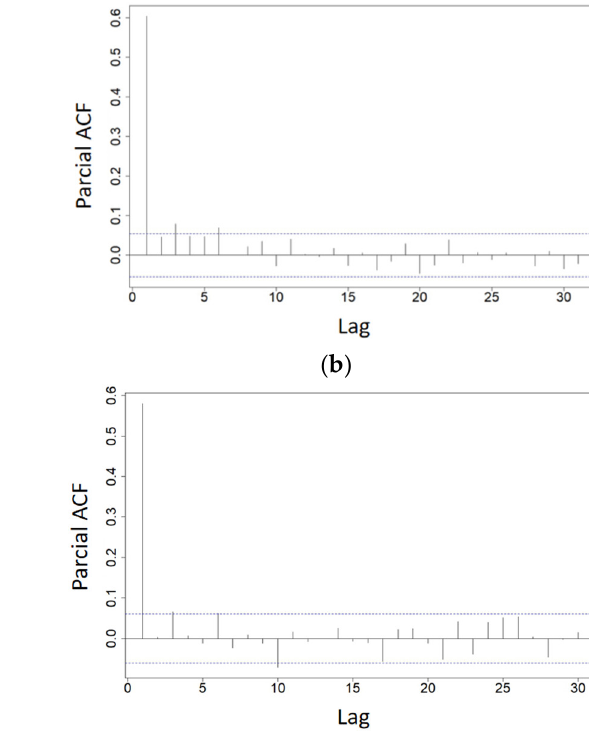
Figure 15. Quantile–quantile plots of the remainder components. ( a ) Shows the quantile–quantile plots of the remainder component corresponding to the original data and ( b ) shows the quantile– quantile plots of the remainder component corresponding to the calibration data without the first 250 days.